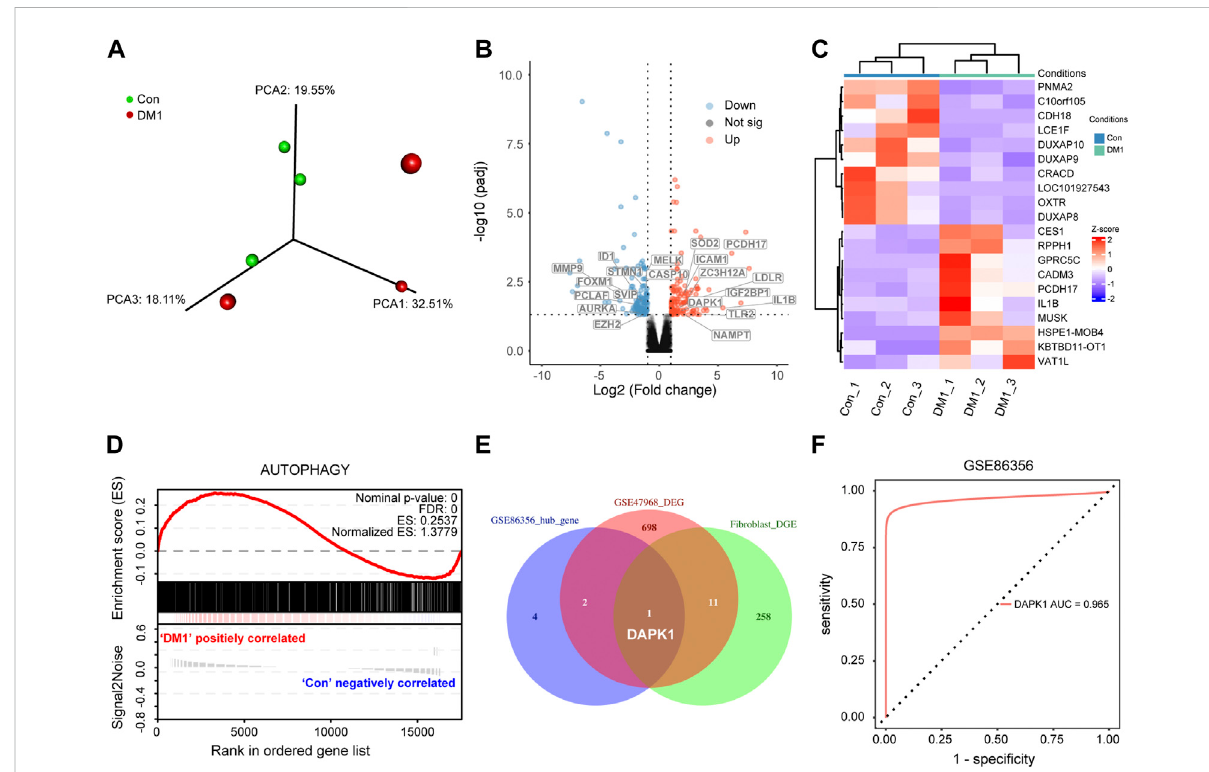
FIGURE 5 Screening of Autophagy-related hub gene analysis and visualization. (A) Principal component plot analysis (PCA) of the human skin fi broblasts pro fi les obtained from the healthy subjects and DM1 patients. Red and green colors represent DM1 and control group, respectively. (B) The top 20 differentially ATG were labeled in the heatmap, with red dots representing signi fi cantly up-regulated genes, blue dots representing signi fi cantly down-regulated genes. (C) Transcripts differentially regulated between DM1 and control human skin fi broblasts. (D) Gene set enrichment analysis (GSEA) results show signi fi cant enrichment of autophagy in DM1 based on the autophagy-related genes signature. (E) Venn diagram which identi fi ed the intersection expressed genes among three gene sets. (F) Receiver operating characteristic (ROC) analysis was used to evaluate the diagnostic performance of DAPK1 for DM1 in GSE86356. Con, control; DM1, myotonic dystrophy type 1; DEG, differential expression genes.